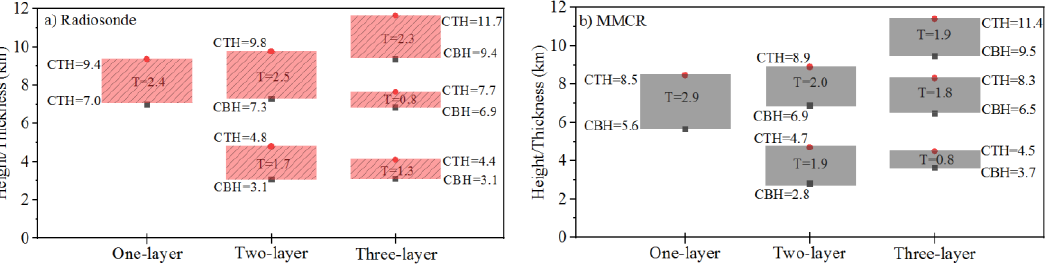
Figure 10. Vertical distributions of the average CBH, CTH, and cloud thickness. ( a ) CVSs observed by the radiosonde and ( b ) CVSs observed by the MMCR. T represents the geometric average thickness of the cloud.